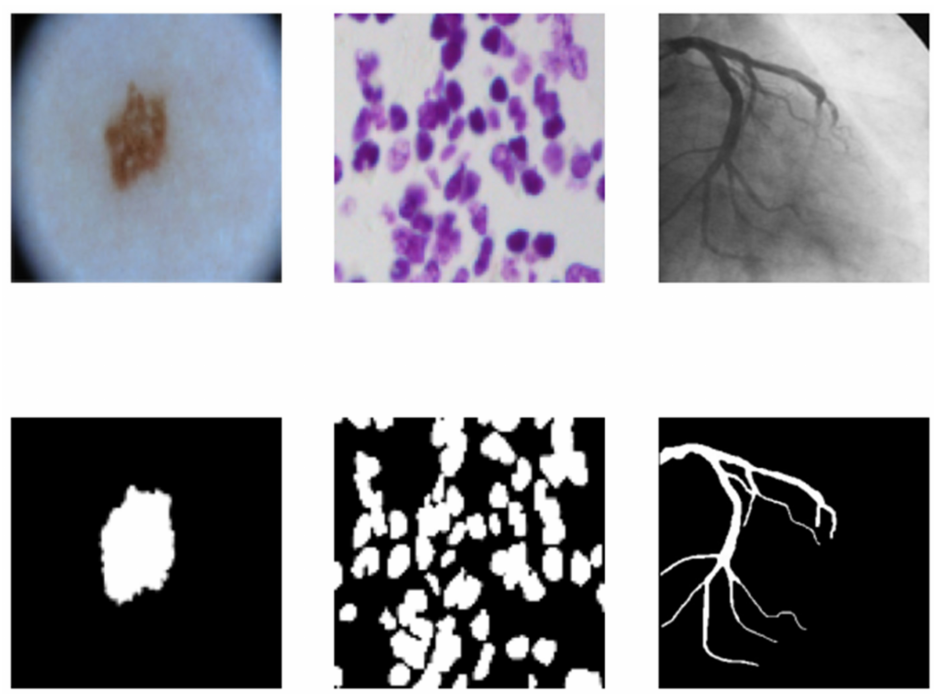
Figure 10. Medical image segmentation: skin cancer on the left , cell nuclei in the middle , and coronary artery in angiography on the right